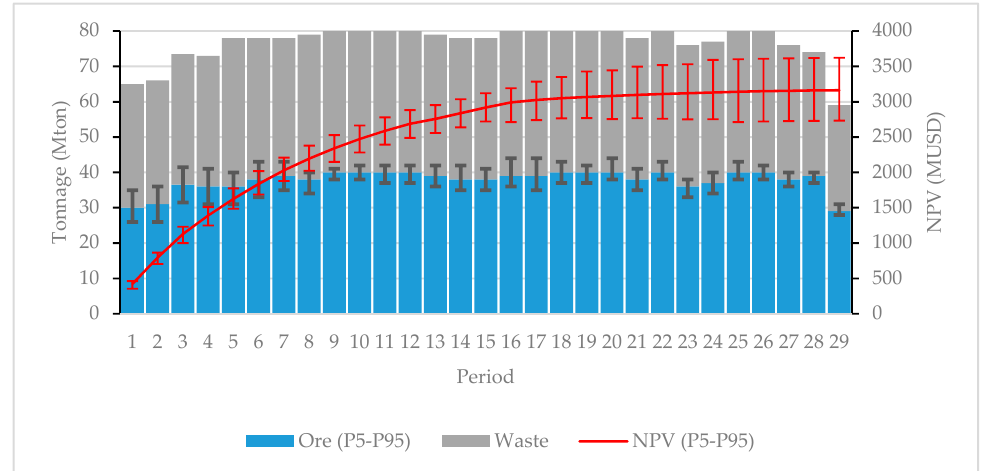
Figure 14. Ore and waste tonnages and net present value from production schedules obtained according (STO) by using scheduling Scheme 3.